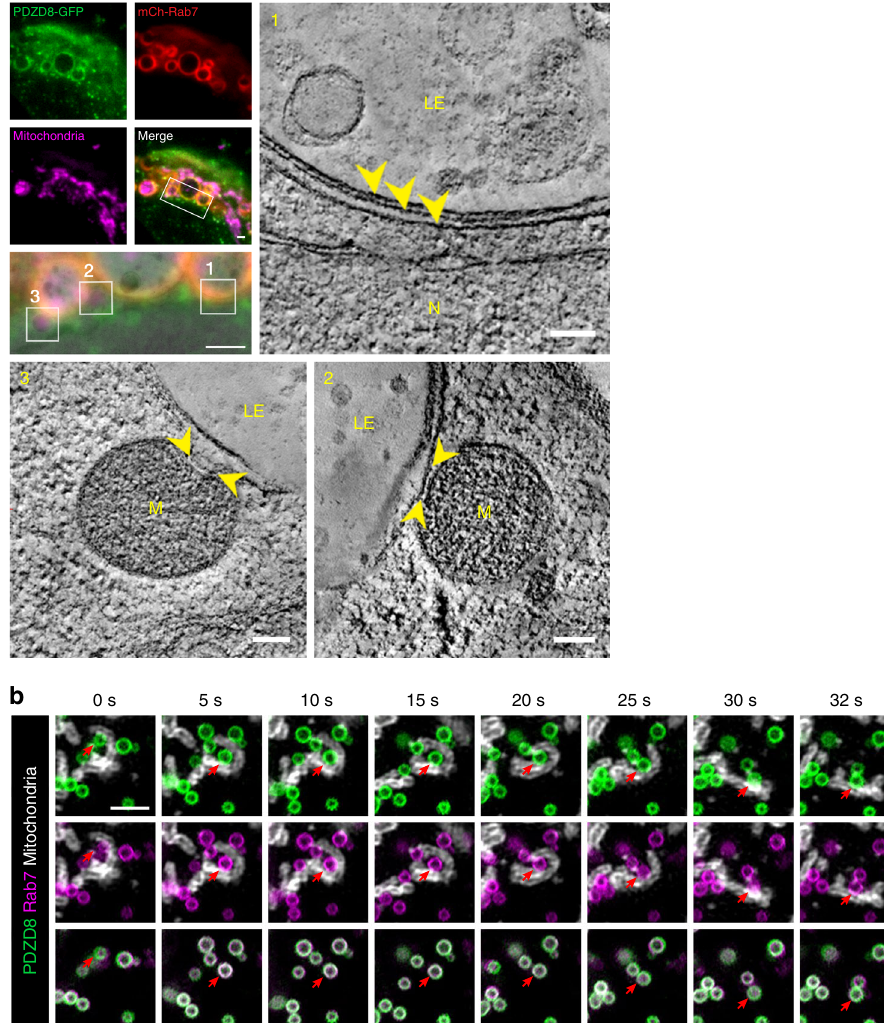
Fig. 5 Mitochondria associate with PDZD8- Rab7 labeled ER-endosome contacts. a Correlative light and electron microscopy (CLEM) analysis indicates regions co-labeled with Rab7 and PDZD8 in cells are contacts between ER, late endosomes and mitochondria. Upper left panel: In-resin fl uorescence images of U2OS cells expressing PDZD8-GFP (green), mCherry-Rab7 (red, mCh-Rab7) and MitoTracker DeepRed (magenta). Rectangle area on merged image corresponds to the magni fi ed image under the panel (left middle), which is an overlay of the transmission electron micrograph and in-resin fl uorescence images. Scale bars: 1 μ m. Boxed regions, labeled 1 – 3 correspond to slices from 3D electron tomograms (upper and lower right and left images). Arrowheads in (1) indicate three membrane bilayers corresponding the late endosome membrane and two membranes of an ER tubule; Scale bar: 100 nm. Measured distance between the membranes of ER and LE is ~15nm. Arrowheads in (2 – 3) mark the proximity of mitochondria to the ER-late endosome contact site. The CLEM experiment was repeated twice from independent samples of transiently transfected cells. TEM tilt-series for tomographic reconstruction were acquired from three individual cells that exhibited fl uorescence of all three markers (PDZD8-GFP, mCherry-Rab7 and MitoTracker DeepRed). Scale bar: 100 nm. Late endosome (LE), mitochondria (M), and nucleus (N). b Mitochondria are persistently localized with late endosomes in contact with PDZD8 ER subregions. Time lapse GI-SIM imaging of BFP-Rab7 labeled endosomes in cells expressing PDZD8-GFP. Red arrow indicates a PDZD8-Rab7 mediated ER- LE-mitochondria contact site. Representative images from eight independent GI-SIM imaging sessions. Scale bar: 2 μ